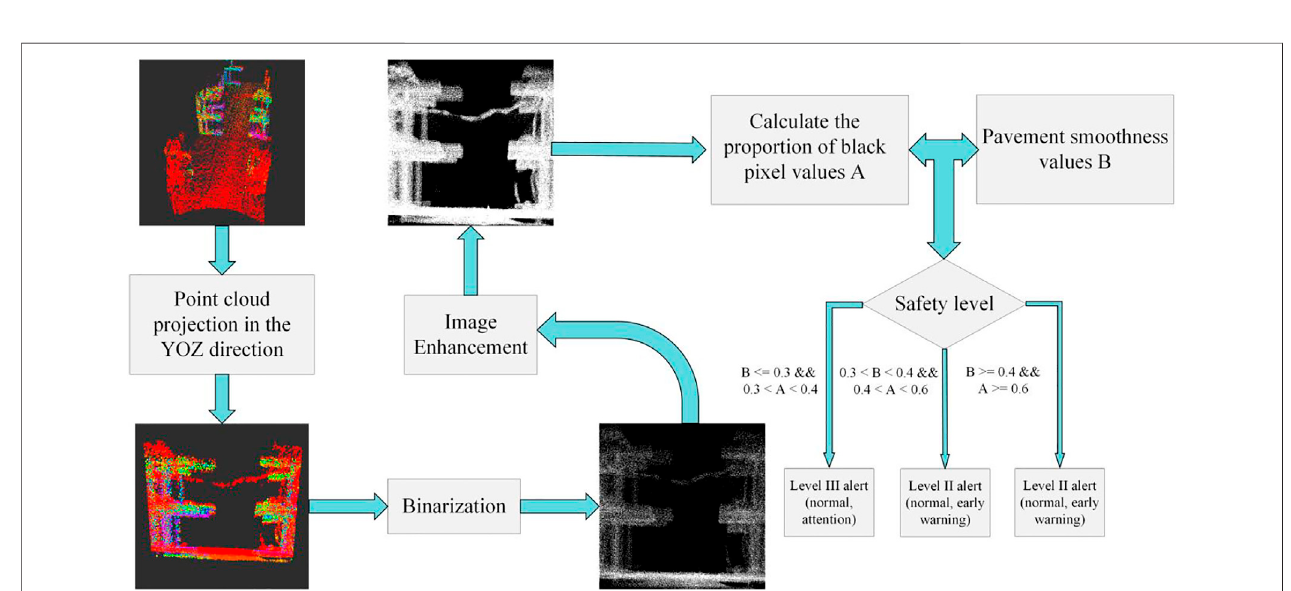
FIGURE 6 | Flow chart of cable trench traf fi cability